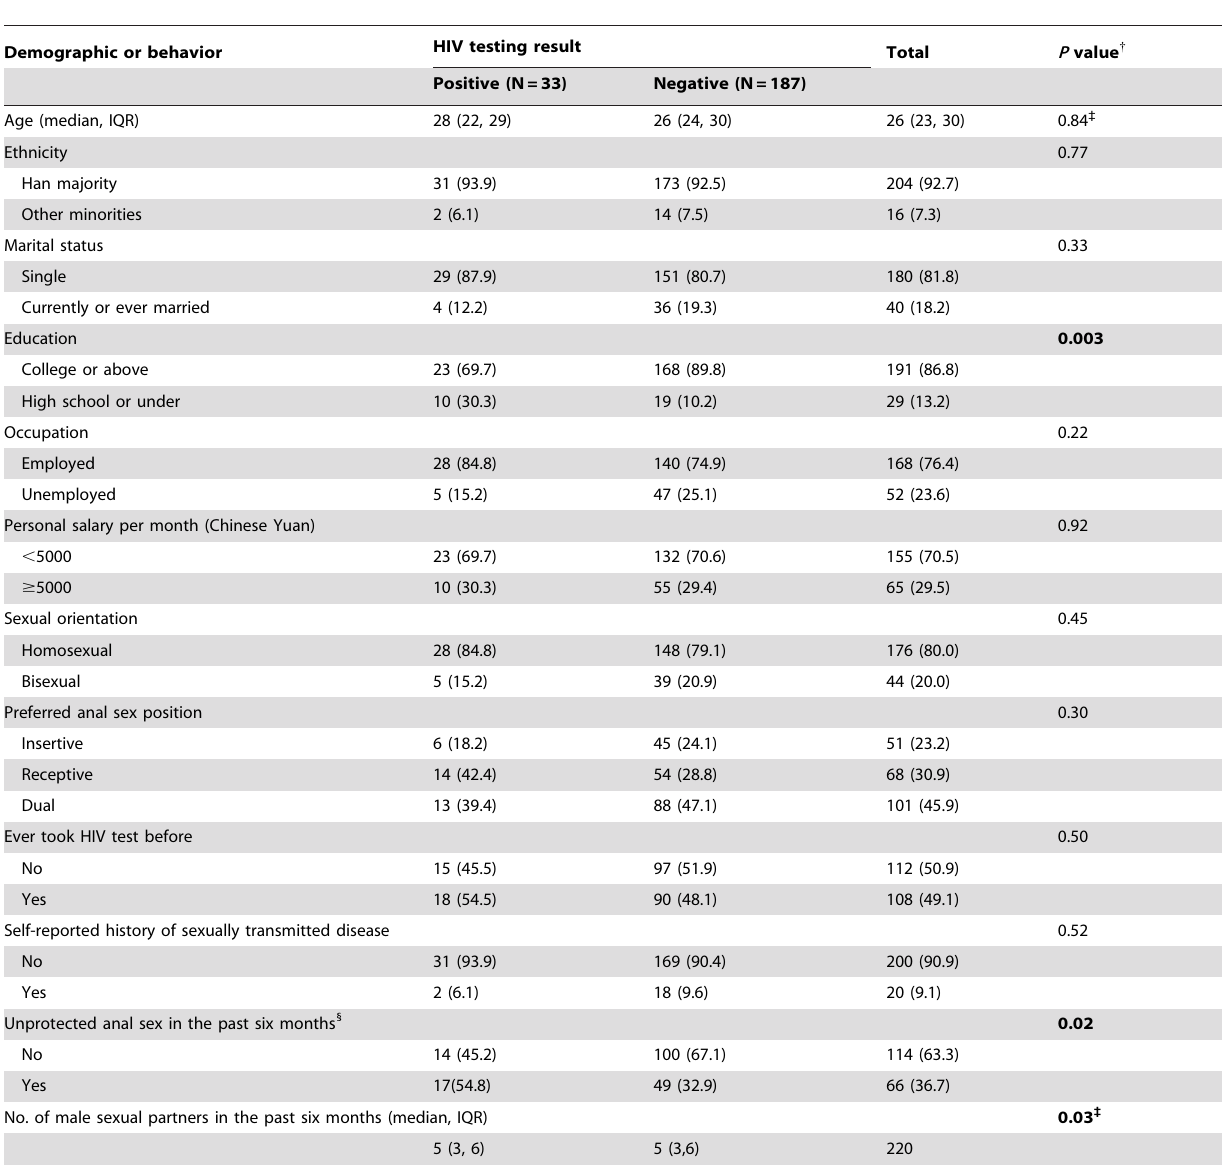
Table 1. Socio-demographic characteristics and sexual behaviors among Chinese men who have sex with men who took HIV home